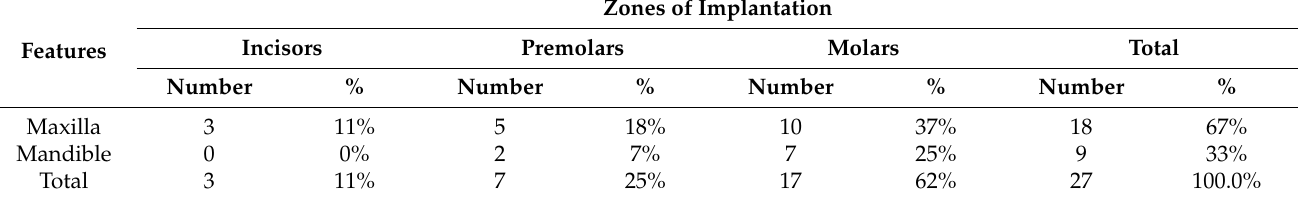
Table 2. Zones of implantation.